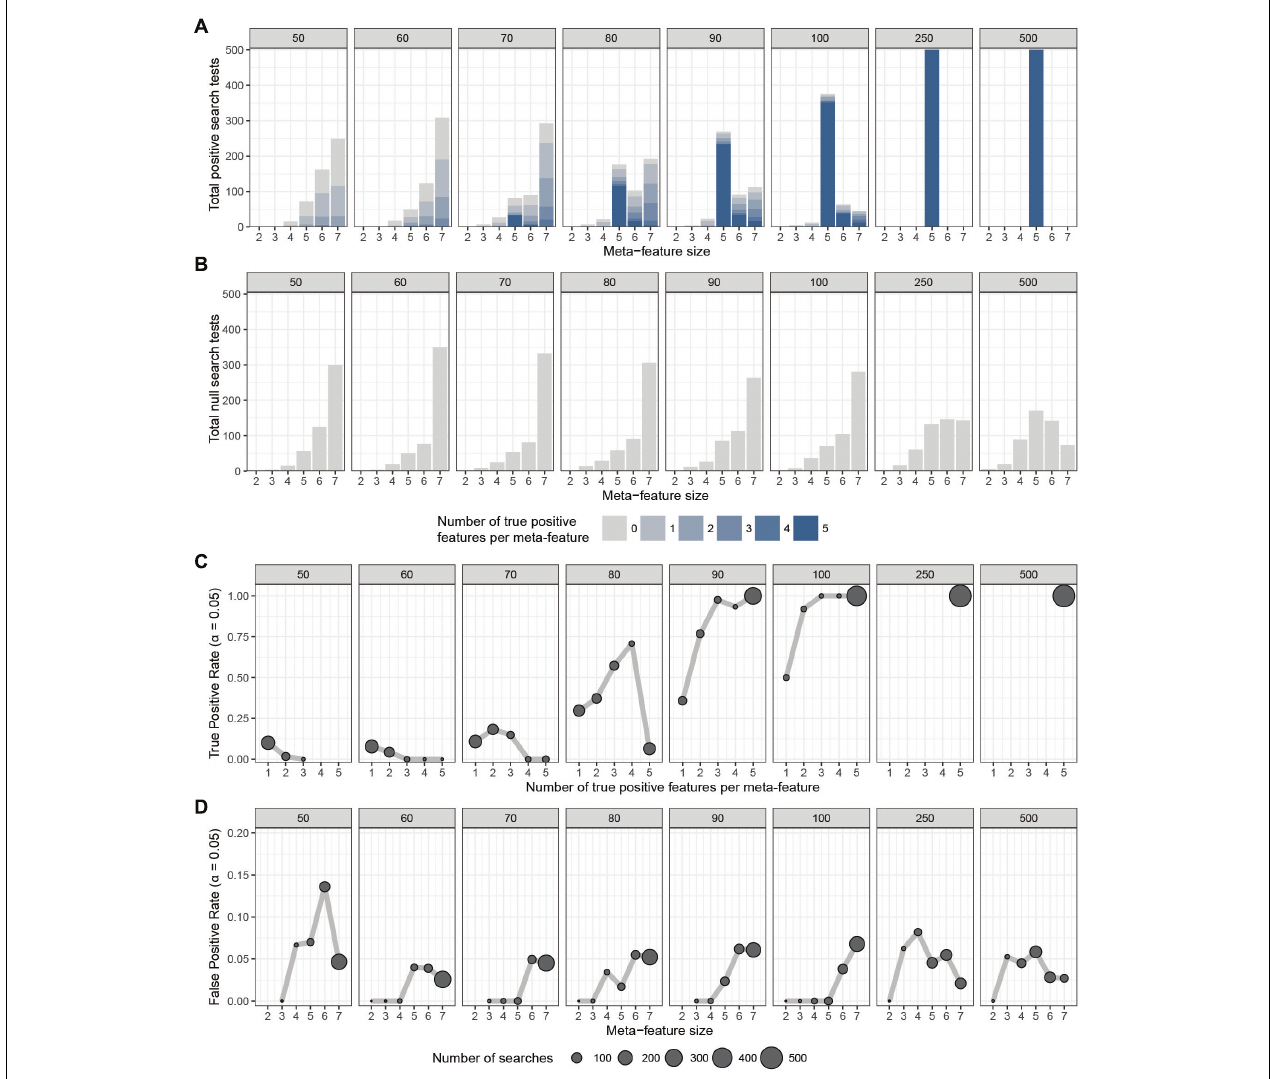
FIGURE 2 | CaDrA performance on simulated data. CaDrA was run on 500 independent simulated datasets containing (A) both positive and null, and (B) only null features with sample sizes ranging between 50 and 500 samples (number in gray box above each sub-panel). In each case, the distribution of the number of features per meta-feature (i.e., the meta-feature size) returned by CaDrA is shown (A,B) as well as the number and fraction of searches that yielded significance for α = 0.05 (C,D) , corresponding to the true positive rate (TPR) and false positive rate (FPR),